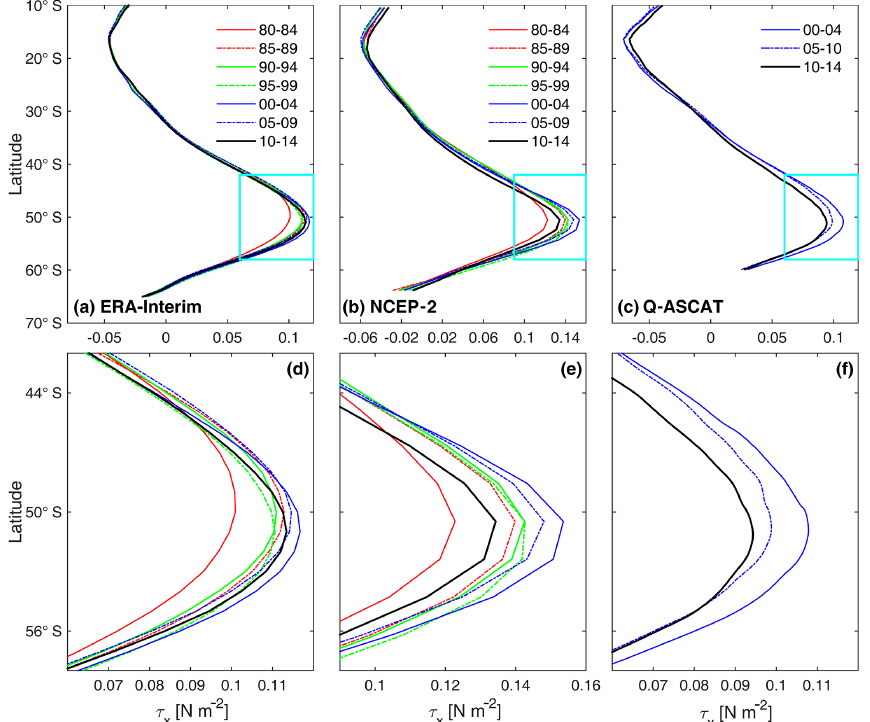
Figure 7. Zonally averaged wind stress calculated from the wind product of (a) ERA-Interim, (b) NCEP-2 and (c) QuikSCAT–ASCAT over the Indian Ocean (20–110 ◦ E) for different periods (i.e. 80–84 for January 1980–December 1984; 00–04 for January 2000–December 2004) listed in the top-right corners. Panels (d, e, f) are the magnification of cyan boxes in (a, b, c) ,